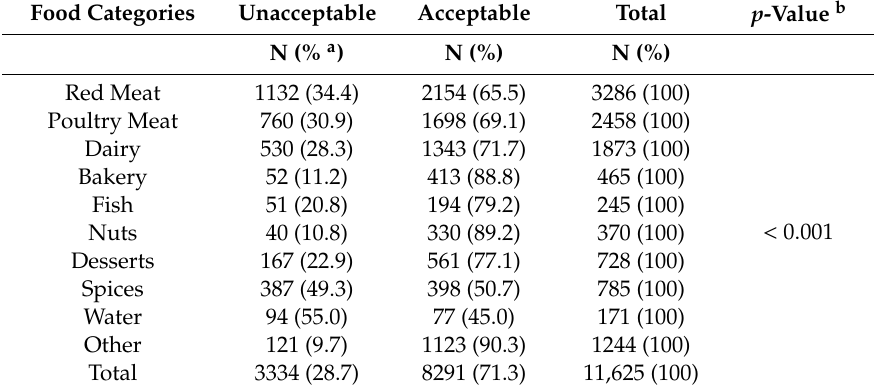
Table 1. The number of samples in each food category that were found to be microbially unacceptable or acceptable based on the reports of the Ministry of Public Health (MoPH) in Lebanon. Samples were rejected due to spoilage and / or because they were deemed to pose a food safety risk to consumers.